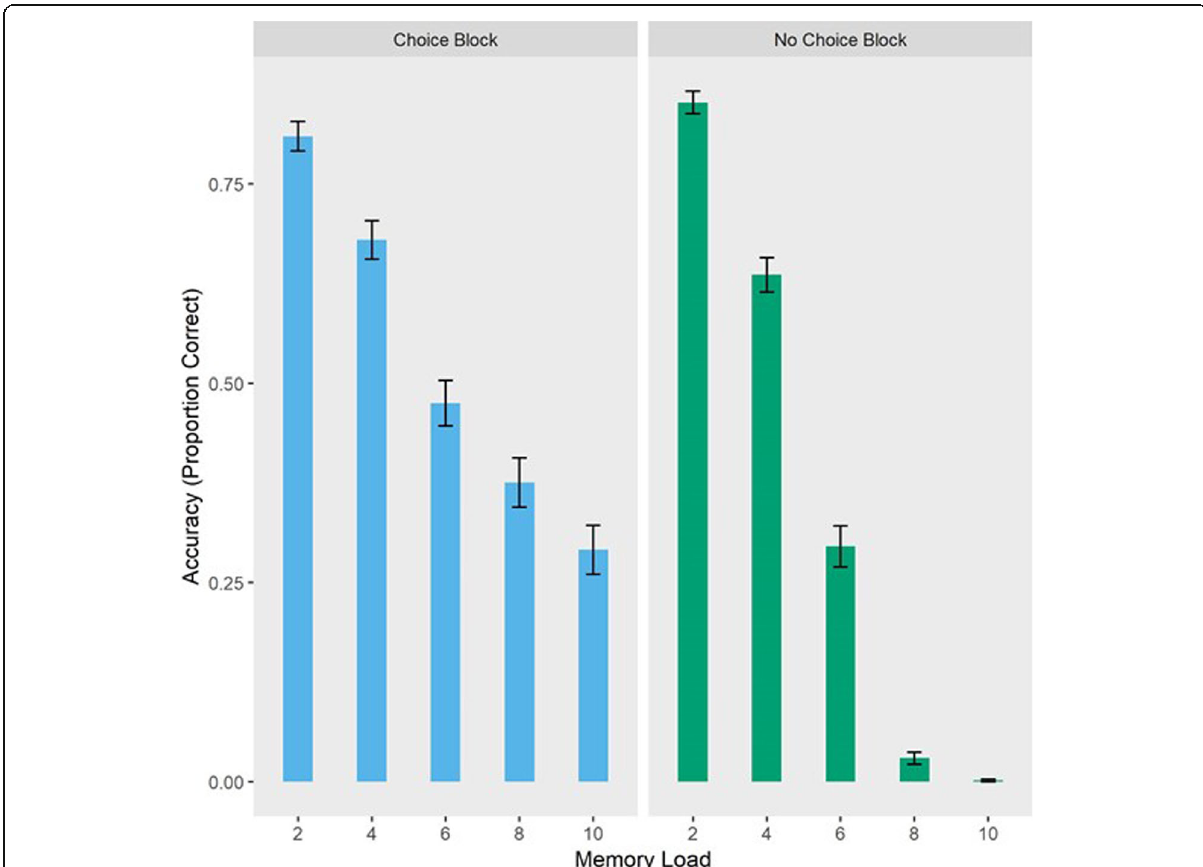
Fig. 2 Average performance by set size in the choice block (where the participants could offload items from memory) and the no-choice block (where they had to rely on internal memory). Error bars denote standard